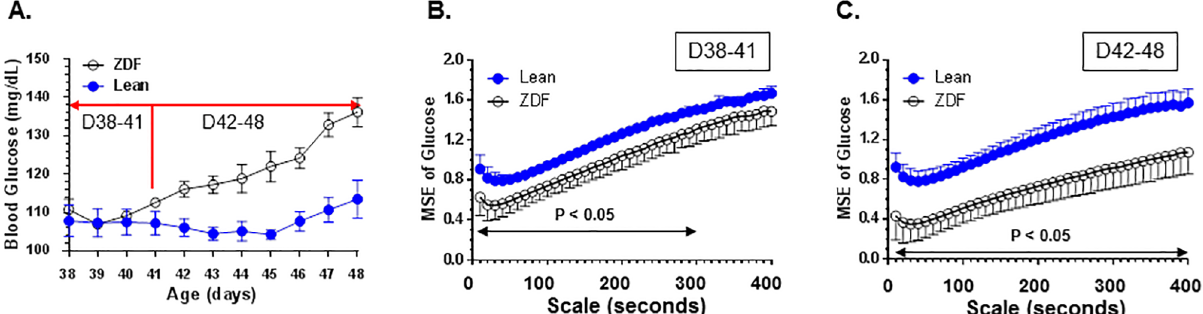
Fig 3. ( A ). Glucose levels of young ZDF rats and age-matched lean controls used for the study. Daily mean glucose levels of ZDF rats or controls from the age of 38 days through the age of 48 days were plotted. N = 4 rats/grouop. D38-41, age Day 38 to Day 41; D42-48,age Day 42 to Day 48. Glucose levels were not significantly different betweenZDF rats and lean controls duringthe age of Day 38 to Day 41 (D38-41)but were statisticallydifferent duringthe age of Day 42 to Day 48 (D42-48). ( B ). Reducedmultiscale entropy in ZDF rats compared with age-matched controls when glucoselevels were not different at the age of D38-41.( C ). Further declineof multiscaleentropy in ZDF rats comparedwith age-matched controls duringthe transition to hyperglycemia at the age of D42-48.The P values in Fig 3B and 3C were calculatedby performing unpairedt-tests for differencesin mean sample entropy between the two groupsof mice at the times scales indicated.